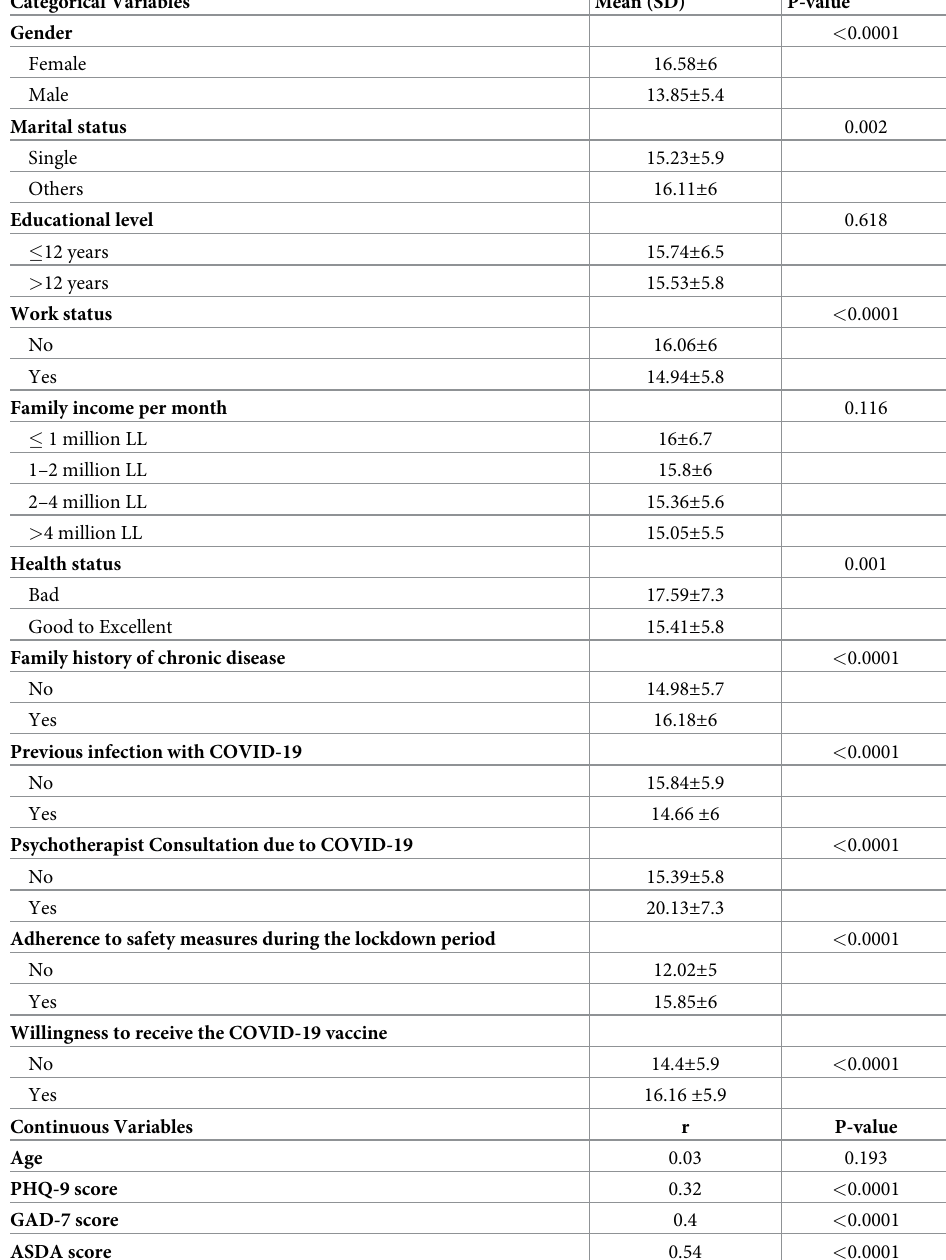
Table 3. Bivariate analyses investigating the possible predictors of the FCV-19S among the study participants (N = 1840). Categorical